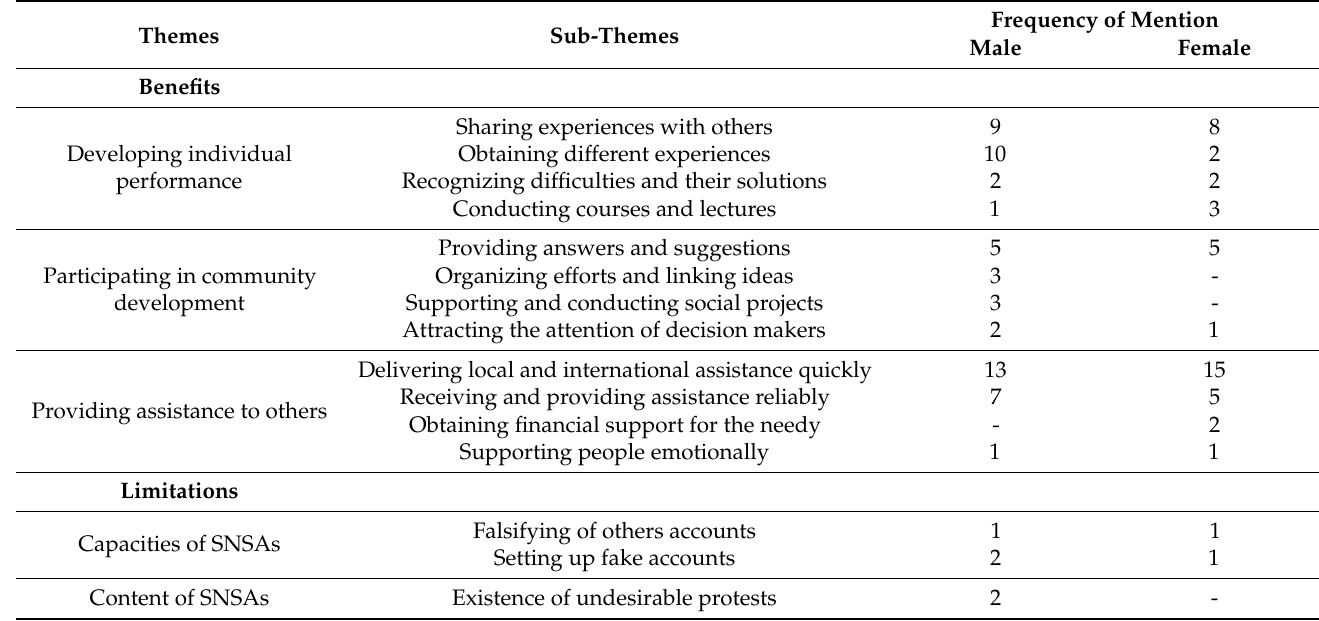
Table 10. Themes relating to SNSAs and civic participation.